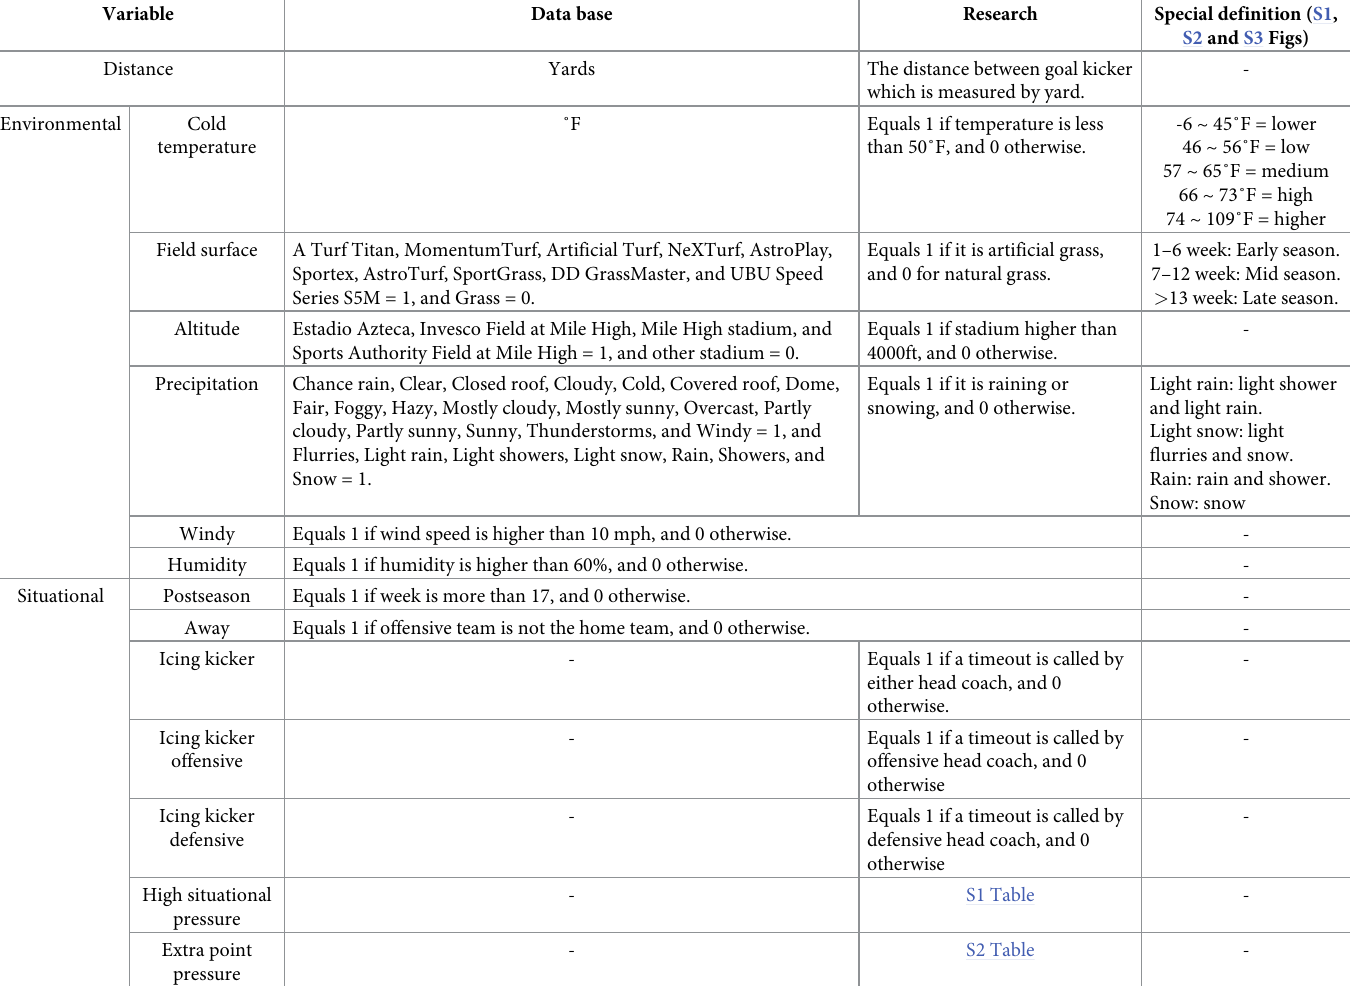
Table 1. Detailed definitions of